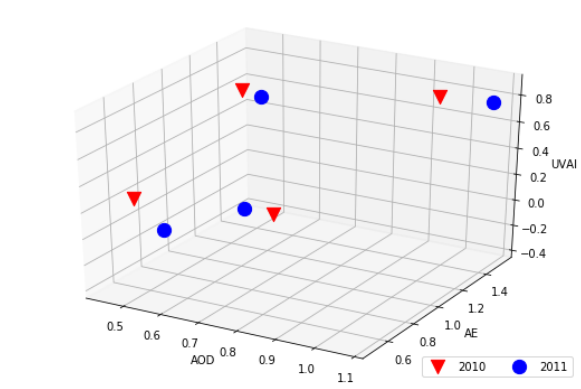
Figure 2. 3-dimension scatter plot of the centres of each cluster in year 2010 and